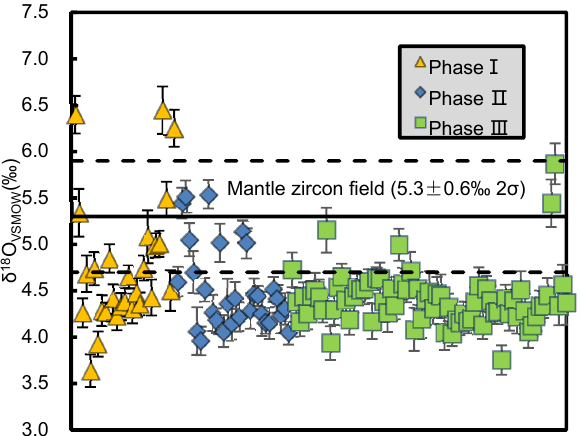
Figure 5. The δ 18 O values of Phase I, II and III zircons. Error bars are 2 σ .